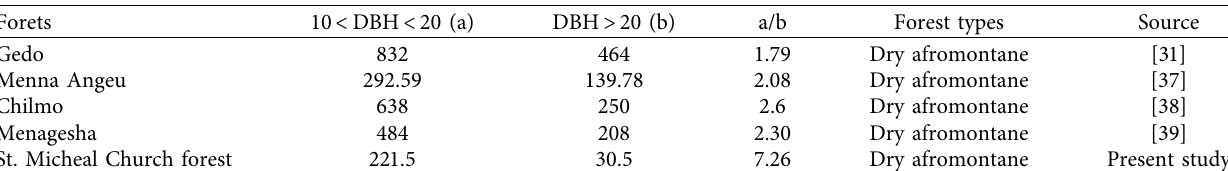
Table 2: Comparison of tree densities with DBH between 10 and 20, and > 20cm of Wonjeta St Michael Church forest with other 4 forests in